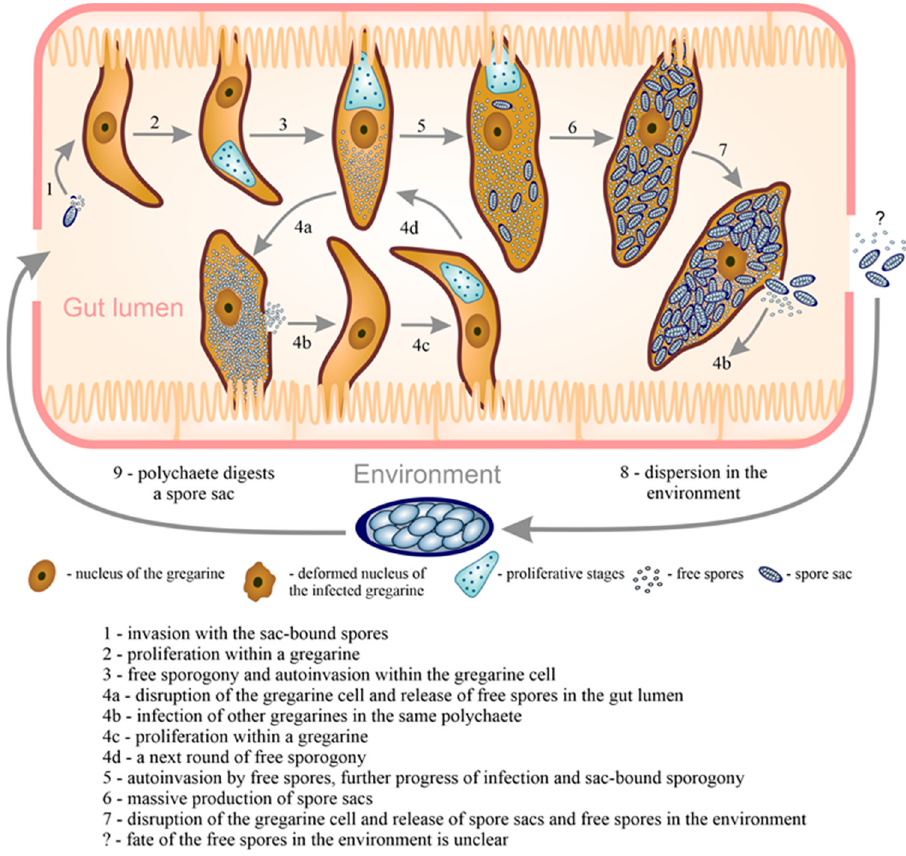
Figure 5. Life cycle of a metchnikovellid and its dispersion within a polychaete host and in the environment. The scheme reflects our current working hypothesis about the development of hyperparasite and its transmission. After invasion ( 1 ), rapid proliferation of hyperparasites begins in the cytoplasm of gregarine cell ( 2 ), followed by free sporogony ( 3 ). Free spores disseminate within the infected gregarine that results in massive production of spores (accumulation of invasive onset) and destruction of the gregarine. As a consequence, free spores disperse in the gut and infect other gregarines ( 4 ). Subsequent infections lead to the production of both free spores and spore sacs ( 5 – 6 ). Spore sacs disperse in the polychaete gut lumen after disruption of the gregarine ( 7 ). Spore sacs disperse into the environment through the intestine of the polychaetes ( 8 ). The cycle is initiated again after a spore sac is ingested by the polychaete ( 9 ).